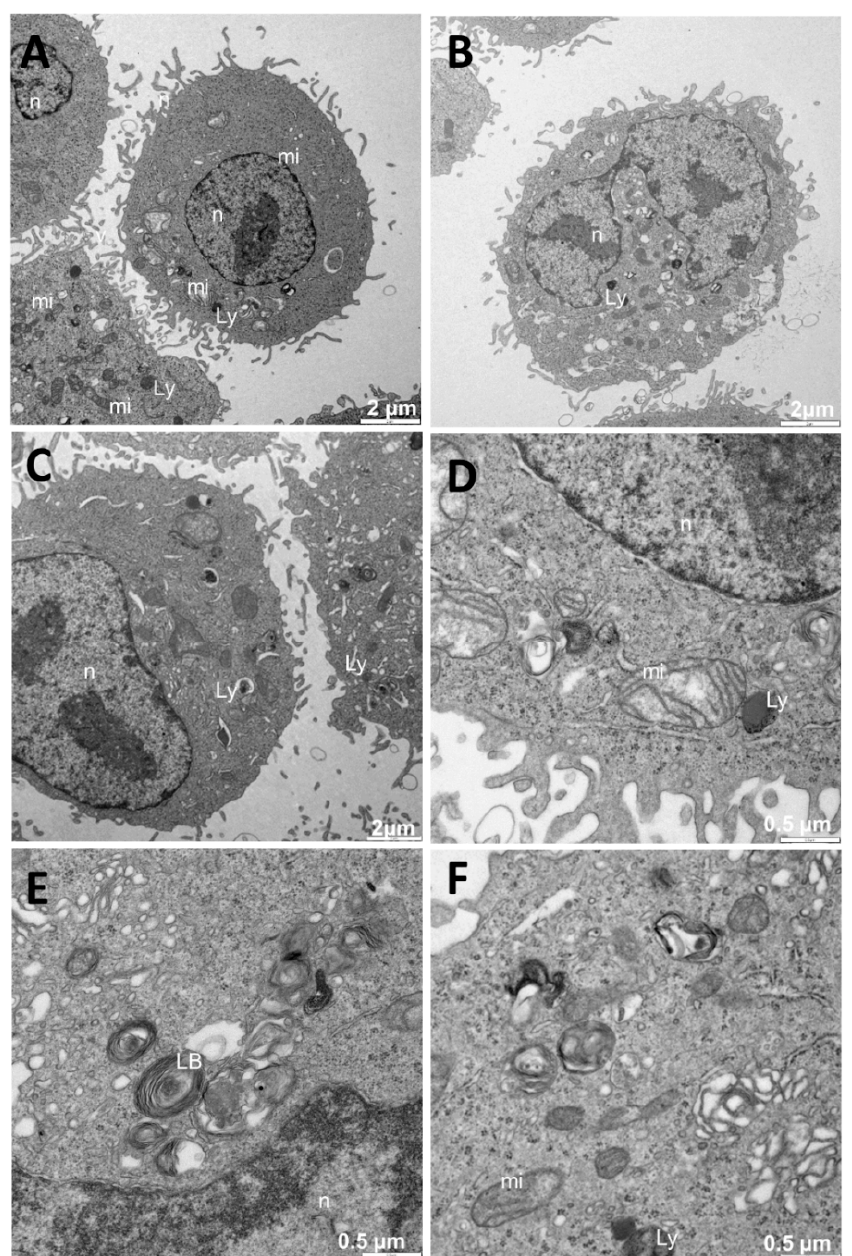
Figure 6. TEM images of A549 cells without any treatment (negative control): ( A – F ) with the typical morphology of the cell type, including the presence of lamellar bodies ( E ). Abbreviations: LBs: lamellar bodies; Ly: lysosome; mi: mitochondria; n: nucleus. With regard to the treatment with free N i nanoparticles at different C Au@16-Ph-16 ,